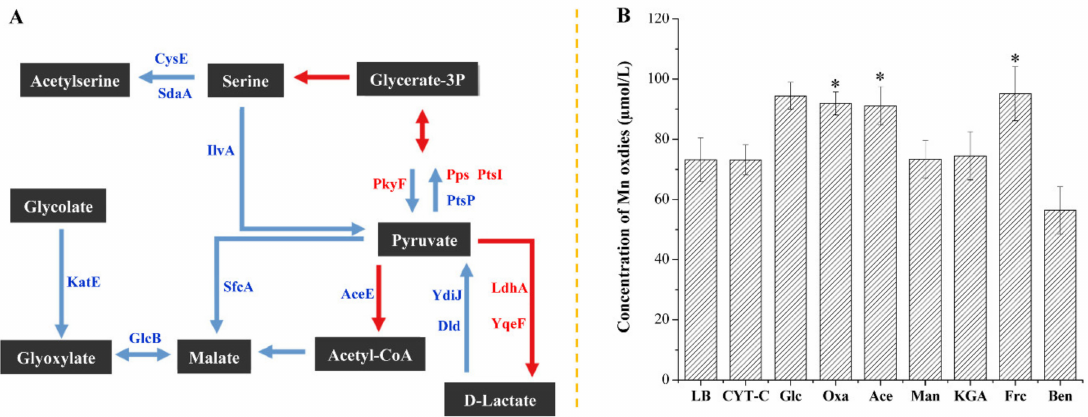
Figure 1. Carbon metabolic pathways potentially associated with Mn oxidation by proteomics analysis ( A ) and the effects of different carbon source substrates on the MnODA of E. coli MB266 suspension ( B ). Red/blue arrows in A indicate significantly upregulated/downregulated metabolic reactions, respectively. Abbreviations are listed as follows: CysE, Serine acetyltransferase; SdaA, L-Serine deaminase I; IlvA, Threonine deaminase; PkyF, Pyruvate kinase I; Pps,